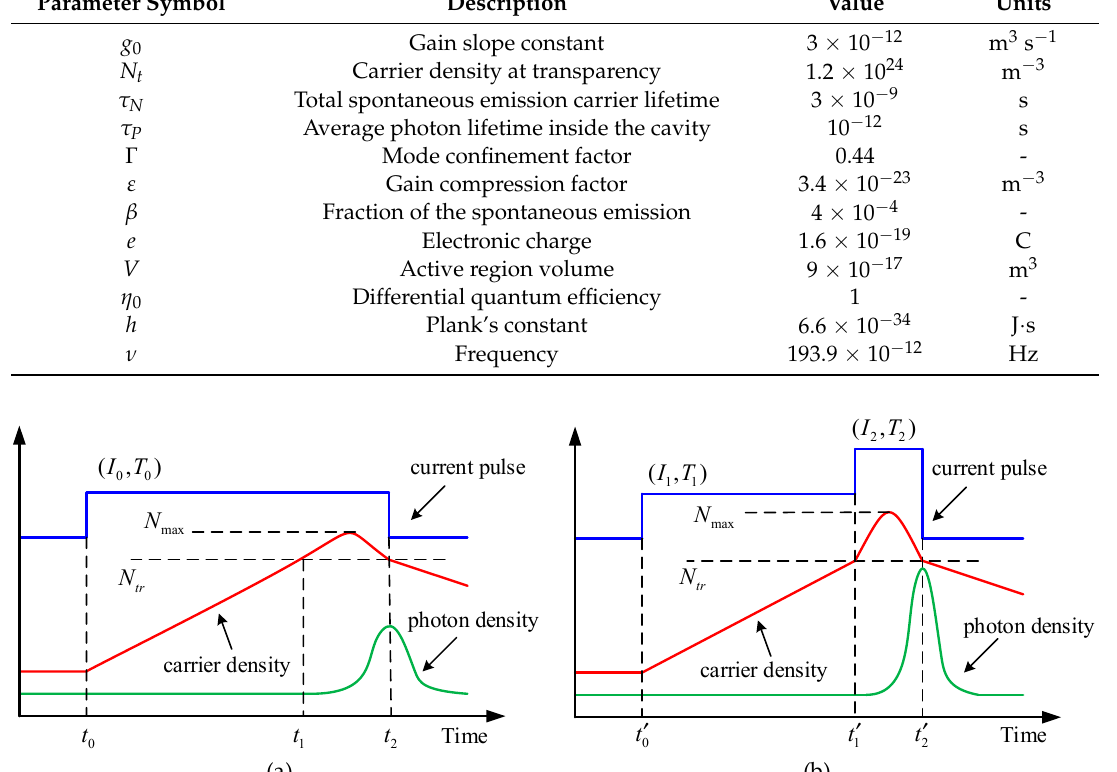
Figure 1. Evolutions in the carrier and photon densities during a gain switch cycle: ( a ) Modulated by rectangular waves; ( b ) modulated by step rectangular wave.